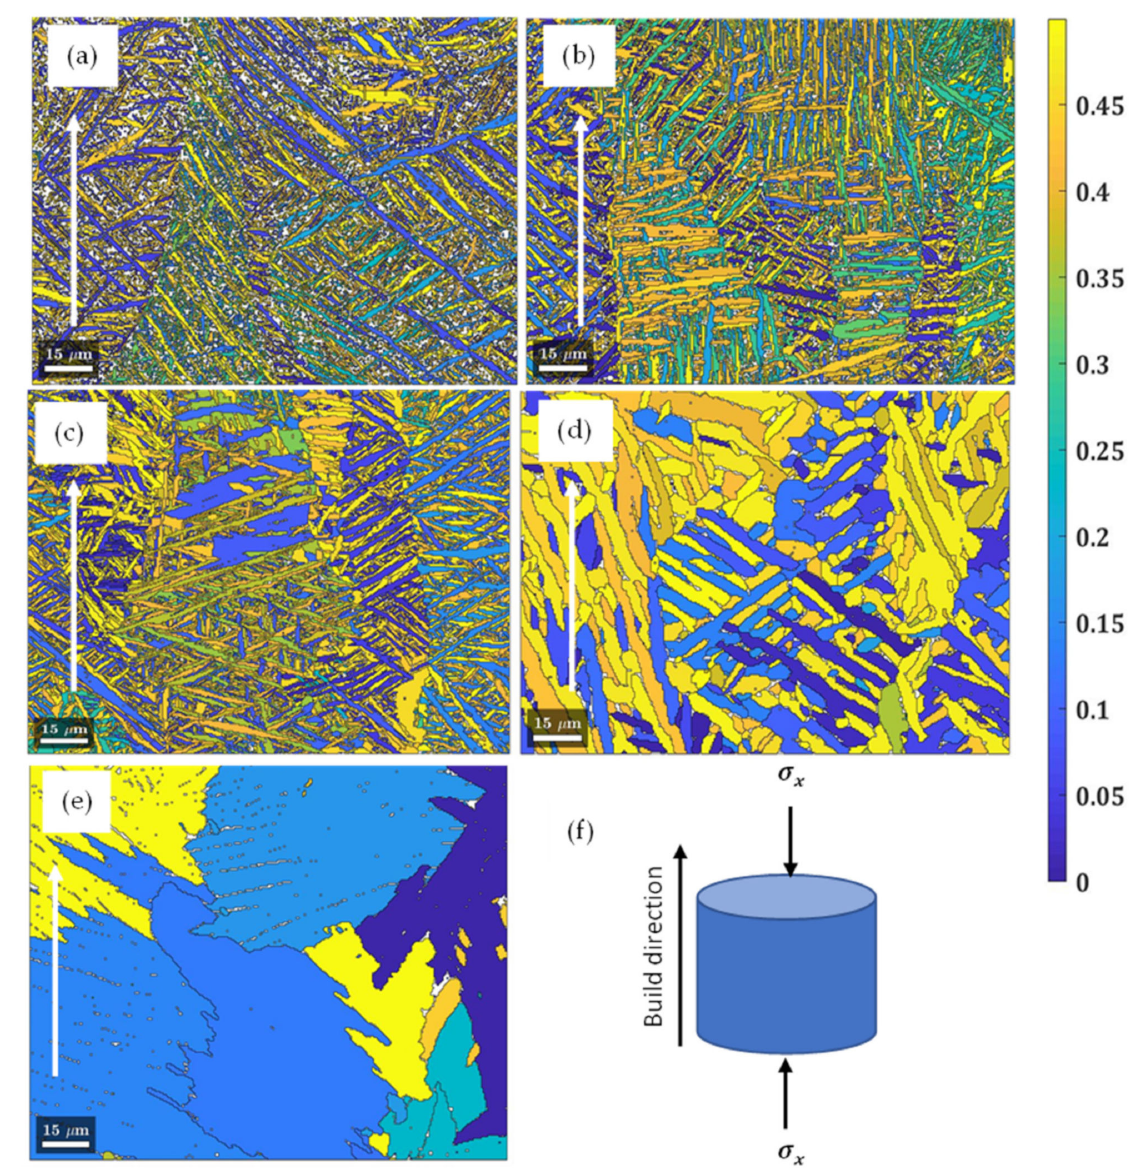
Figure 7. A classical distribution of the global Schmid factor for the basal slip system of α (cid:48) / α -grains in ( a ) samples A, ( b ) samples B, ( c ) samples C, ( d ) samples D, and ( e ) samples E. The direction of the acting stress ( σ x ) used to evaluate the Schmid factor is shown in ( f